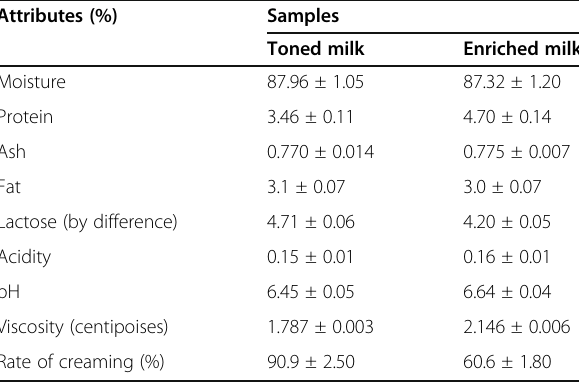
Table 3 Physico-chemical characteristics of enriched and